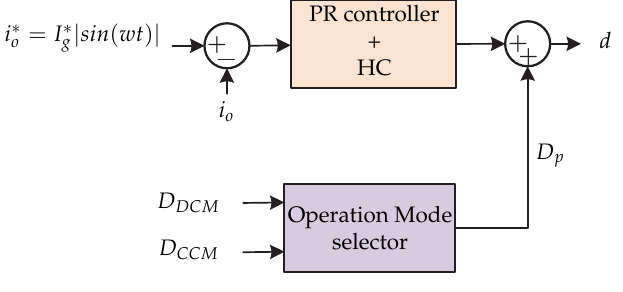
Figure 21. Control strategy proposed in [29].